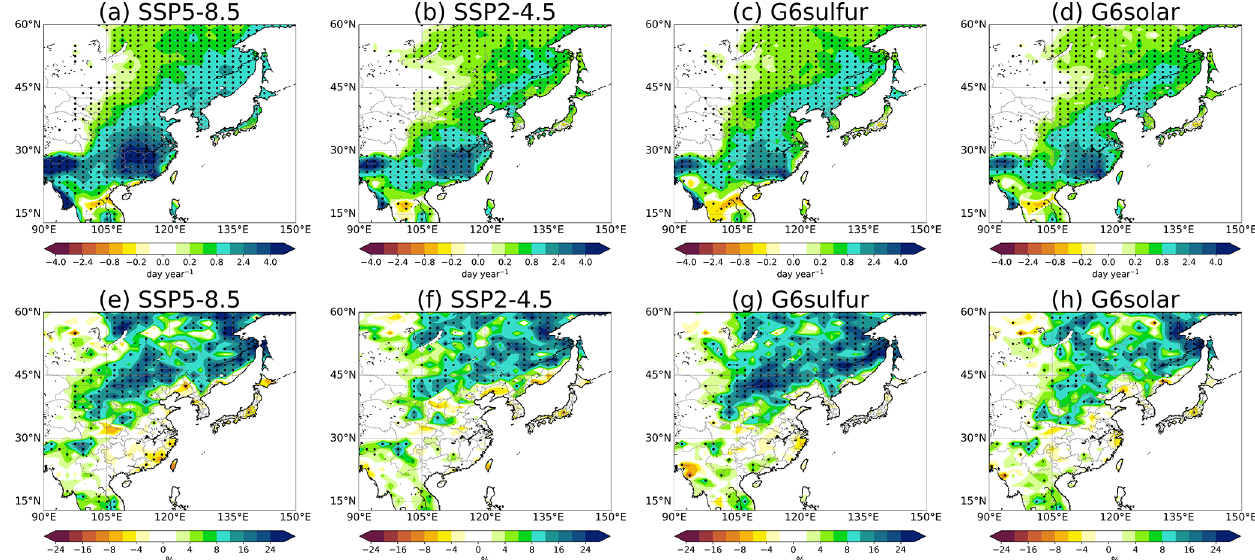
Figure 10. As in Fig. 9 but for the occurrence of AR-related events (a–d) of heavy rain (daily precipitation > 40mm) and the contribution of ARs to the annual total heavy rain events (e–h) .